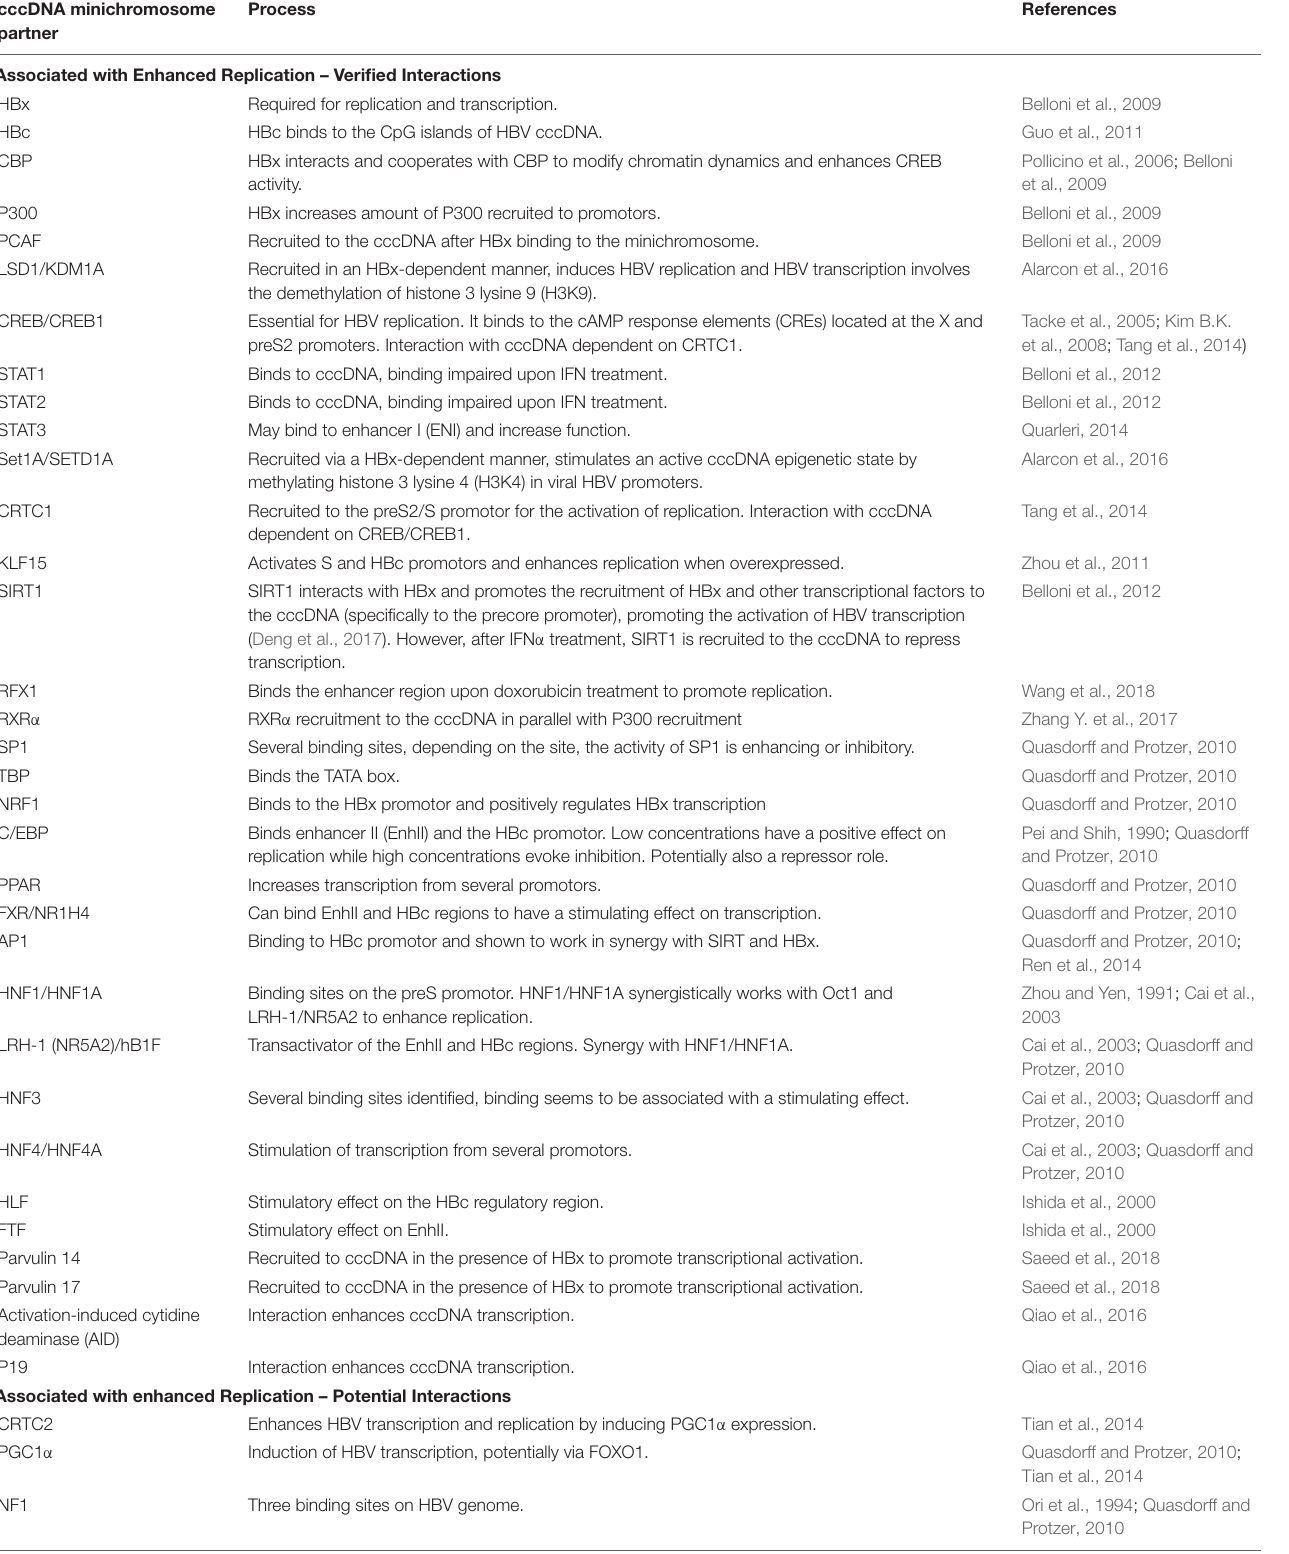
TABLE 1 | List of known protein-cccDNA interactions associated with increased or decreased transcriptional regulation. cccDNA minichromosome partner